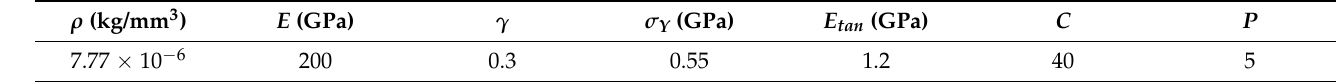
Table 3. Material parameters of the piecewise linear plastic model.